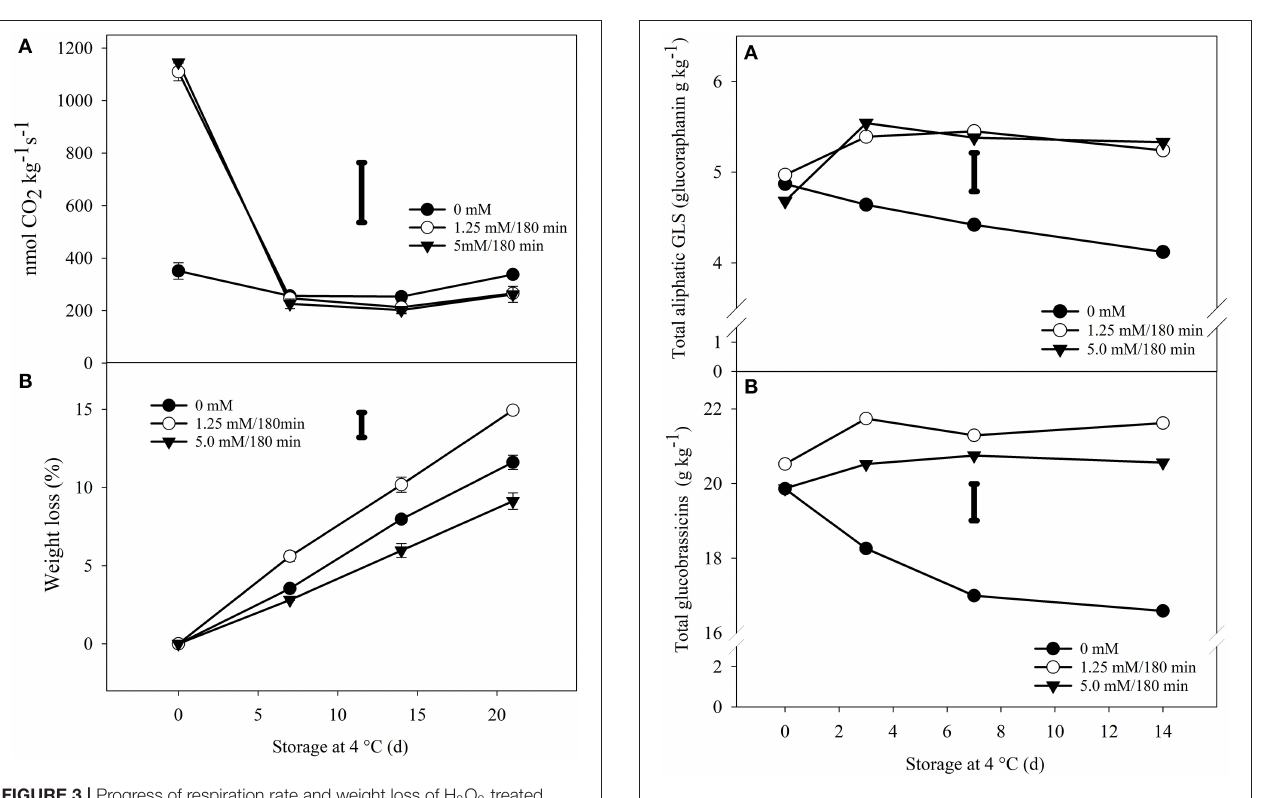
( Table 1 ) . By contrast, a 22% increase on ORAC was